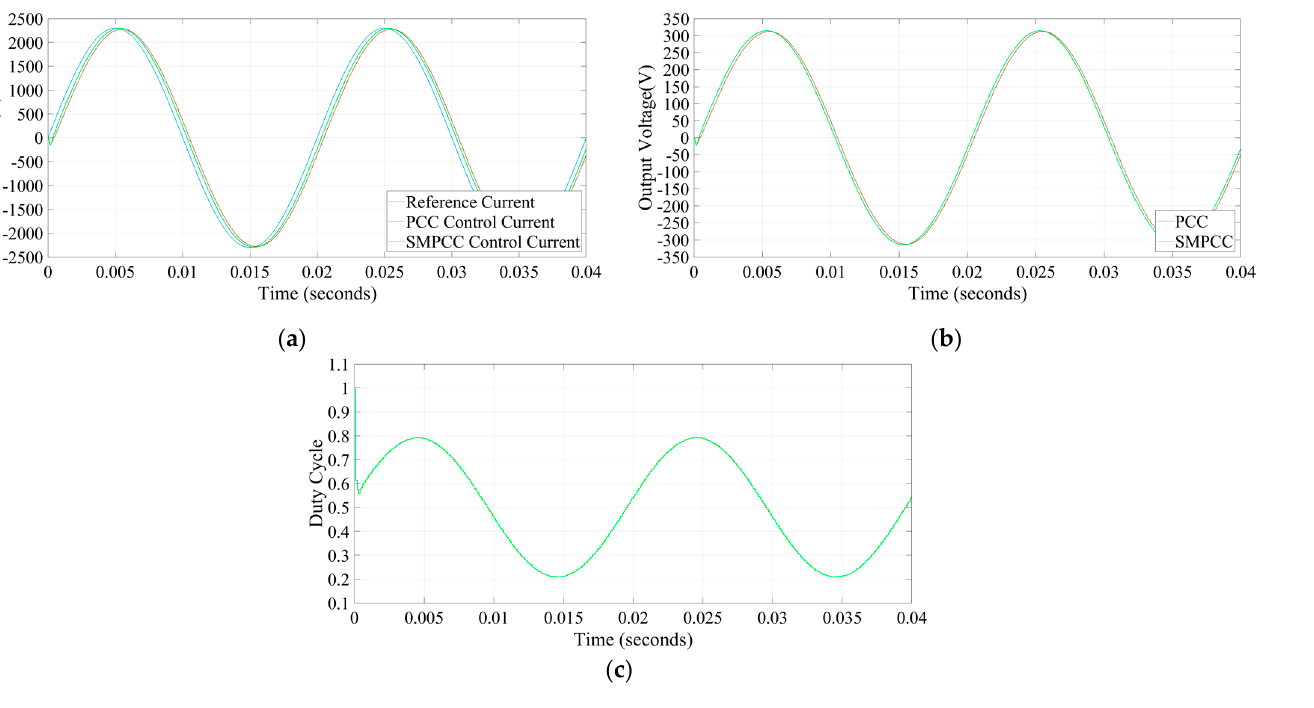
Figure 5. The simulation when the output reference current is sinusoidal. ( a ) The output current changes; ( b ) The output voltage changes; ( c ) The duty cycle changes of M1 and M4 in SMPCC.